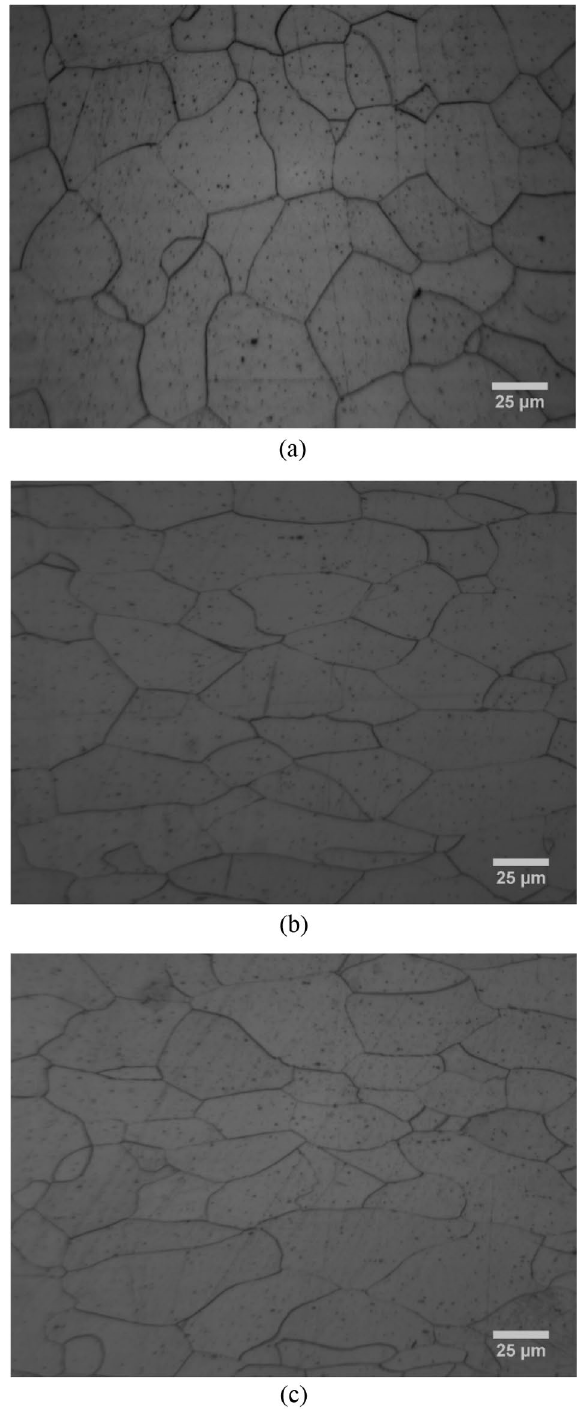
Figure 2. Microstructure of St14 after heat treatment (top), 25% (middle) and 45% (bottom) thickness reduction (100×, Nital 2% for 20